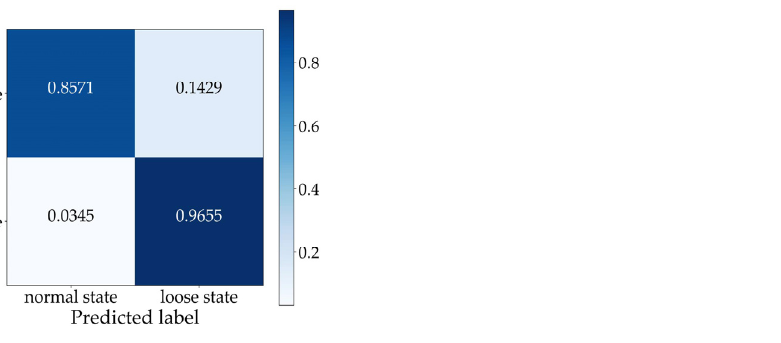
Figure 9. Confusion matrix of the proposed CAE network in the case of the test dataset.